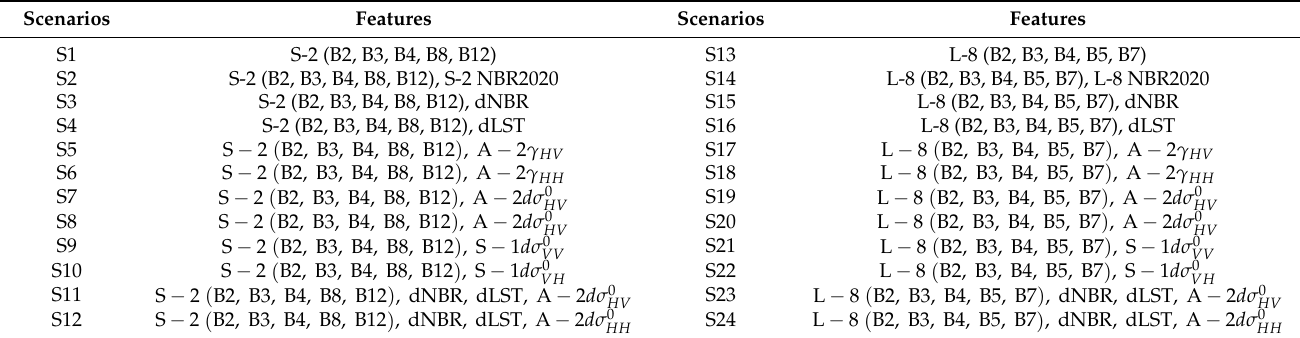
Table 4. The scenarios created for the comparison. S-2 = post-fire Sentinel-2 data, L-8 = Landsat-8,